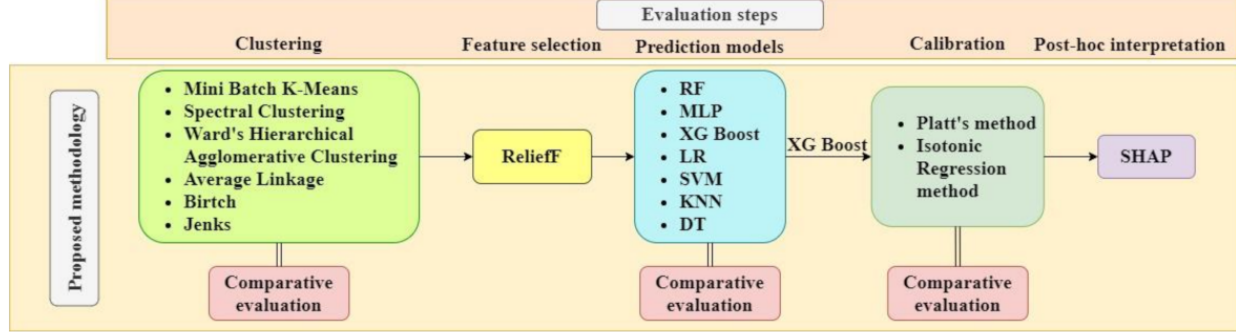
Figure 3. Evaluation methodology.